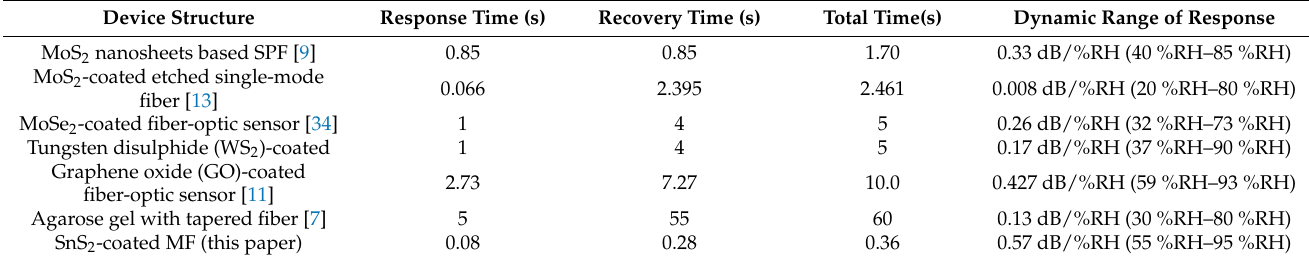
Table 1. Comparison of the main performance between the proposed SnS 2 -coated MF sensor and other recently developed fiber-optic sensing devices in the